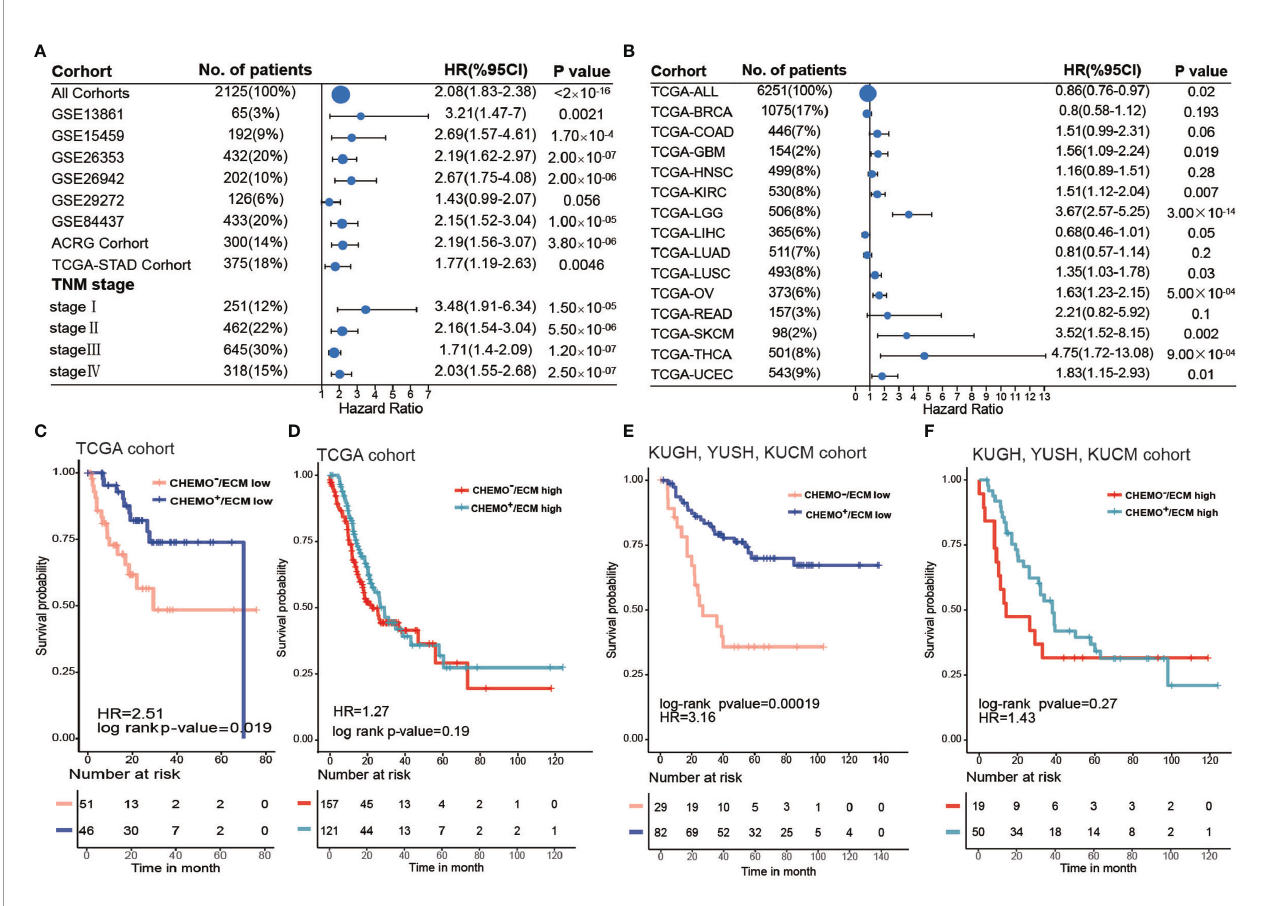
FIGURE 4 | ECM score is a prognostic biomarker and could predict chemotherapy response. (A) Forest plot showing the difference in prognosis between ECM high and low groups in independent gastric cancer cohorts and different tumor stages. The horizontal coordinates represent the hazard ratio of the ECM high group relative to the ECM low group and the horizontal line represents the 95% con fi dent interval of the hazard ratio. The size of the dot indicates the sample size of the independent group. (B) Forest plot showing the difference in prognosis between the ECM high and low groups in 14 types of solid tumors from the TCGA datasets. The horizontal coordinates represent the hazard ratio of the ECM high group relative to the ECM low group and the horizontal line represents the 95% con fi dent interval of hazard ratio. The size of the dot indicates the sample size of the independent group. (C) Kaplan – Meier curves for overall survival of the ECM high group in the TCGA-STAD cohort grouped by chemotherapeutic history. CHEMO - /ECM high, n = 157; CHEMO + /ECM high, n = 121. Log-rank test, p-value = 0.19. (D) Kaplan – Meier curves for overall survival of the ECM low group in the TCGA-STAD cohort grouped by chemotherapeutic history. CHEMO − /ECM low, n = 51; CHEMO + /ECM low, n = 46. Log-rank test, p-value = 0.019. (E) Kaplan – Meier curves for overall survival of the ECM high group in the KUGH, YUSH, and KUCM cohorts grouped by chemotherapeutic history. CHEMO − /ECM high, n = 19; CHEMO + /ECM high, n = 50. Log-rank test, p-value = 0.27. (F) Kaplan – Meier curves for overall survival of the ECM low group in the KUGH, YUSH, KUCM cohort grouped by chemotherapeutic history. CHEMO − /ECM low, n = 29; CHEMO + /ECM low, n = 82. Log-rank test, p-value =